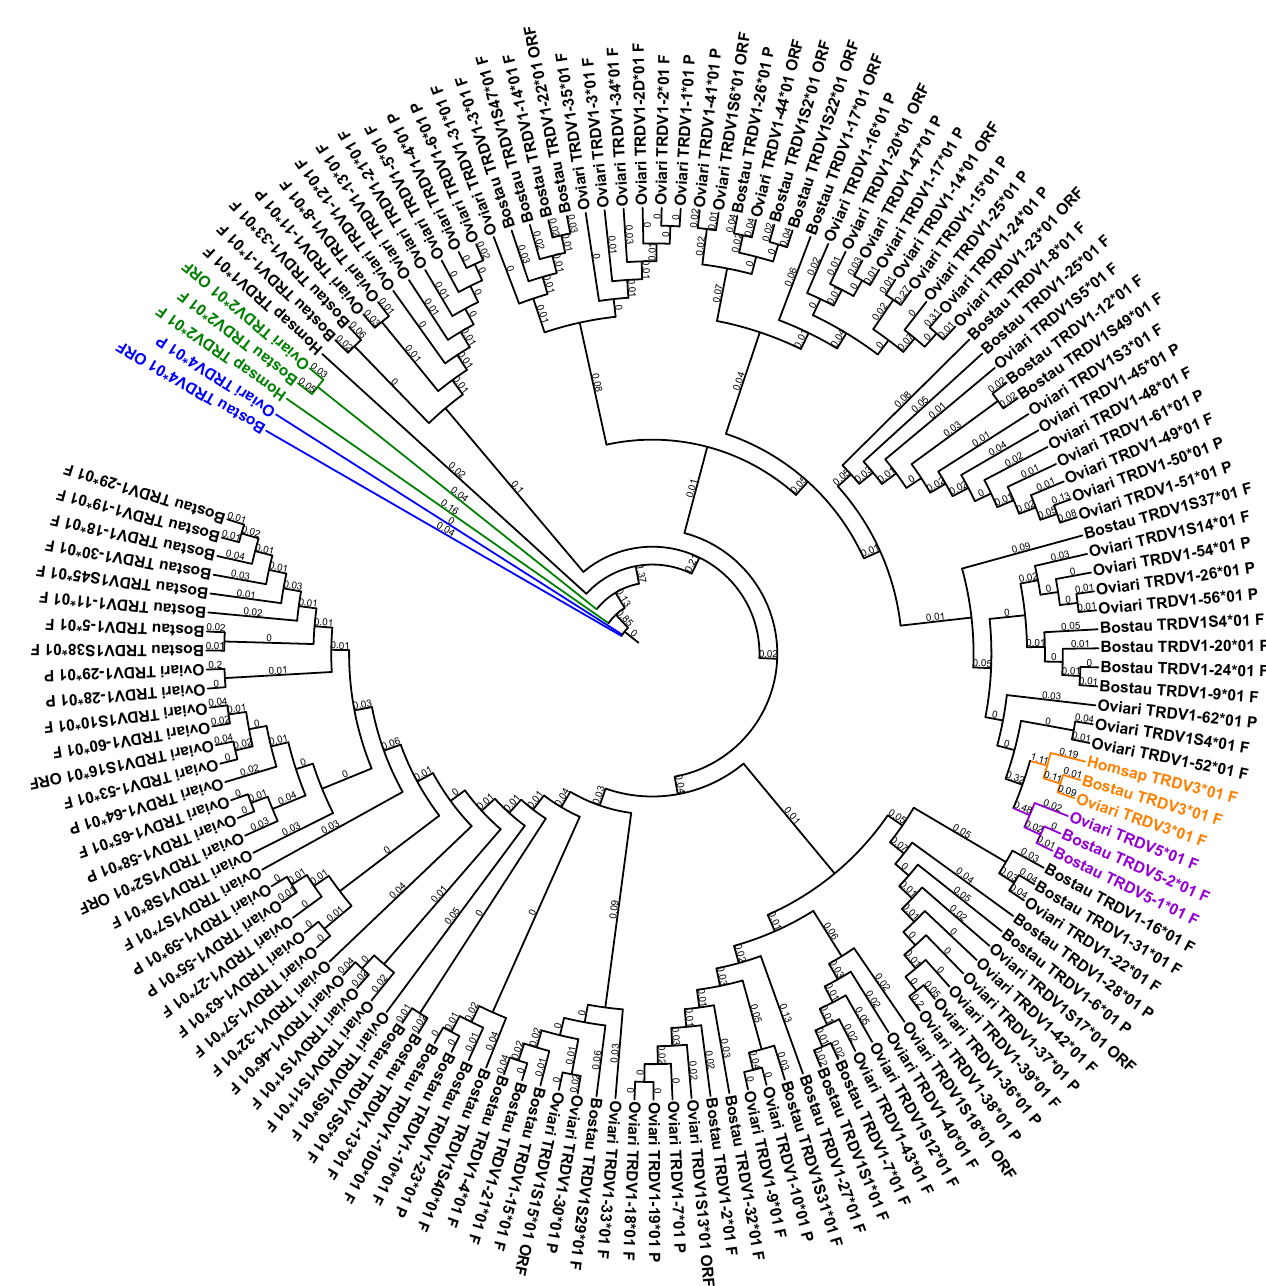
Figure 7. Phylogenetic tree of all TRDV genes for all species (using V-REGION). Homsap: human, Bostau: bovine and Oviari: sheep. The different colors highlight the different subgroups. Tree generated using NGPhylogeny.fr [25] (with MAFFT [26] and PhyML [27] programs) and iTOL v4 [37]. As for the TRAV genes, the number of TRDV genes varies depending on the species. There are fewer genes in human than in bovine and fewer genes in bovine than in sheep (cf. Table 1). There are two new subgroups in bovine and sheep compared to human (TRDV4 and TRDV5) and the TRDV1 subgroup much larger in cattle and sheep with 50 and 84 genes, respectively, compared to 1 in human (cf. Table